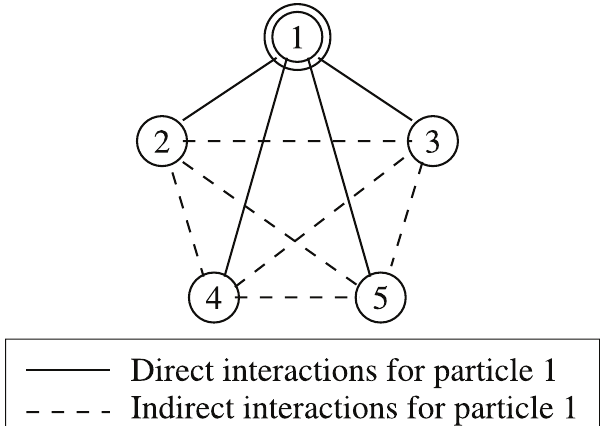
Figure 1. Direct and indirect interactions. For the five particle system shown here, with particle 1 as the selected particle, the direct interactions are shown as solid lines, and indirect interactions as dotted lines.